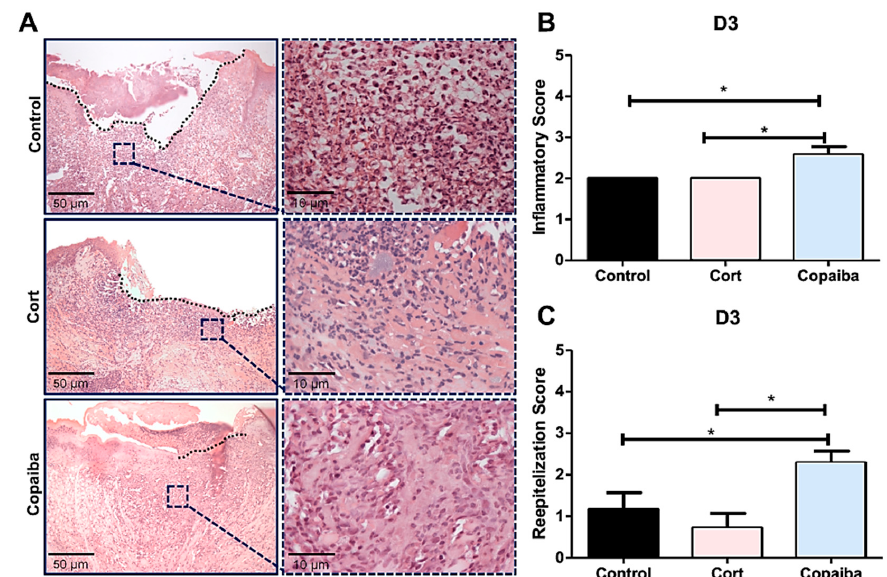
Figure 2. Histopathological analysis of treated and untreated wounds at D3. ( A ) Five- µ m sections stained by hematoxylin and eosin (HE) showing copaiba-treated wounds with predominance of granulation tissue, whereas acute inflammatory cells (neutrophils) predominated in most wounds from the corticoid and control groups. ( B ) Copaiba-treated wounds presented a significantly higher score of the inflammatory stage, which indicates a decreased acute inflammatory reaction and ( C ) a more advanced stage of reepithelization. The corticoid-treated wounds showed lower scores of reepithelization at D3, demonstrating poor tissue repair (original magnification × 200 and × 1000). One-way ANOVA and Tukey’s post hoc tests ( n = 15) (* p < 0.05).